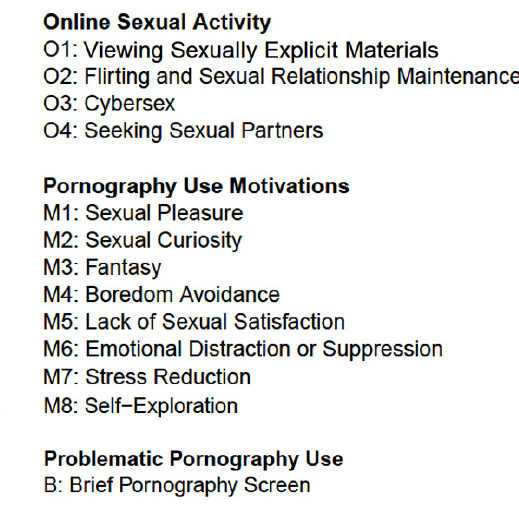
Figure 2. Node centrality plot of strength.